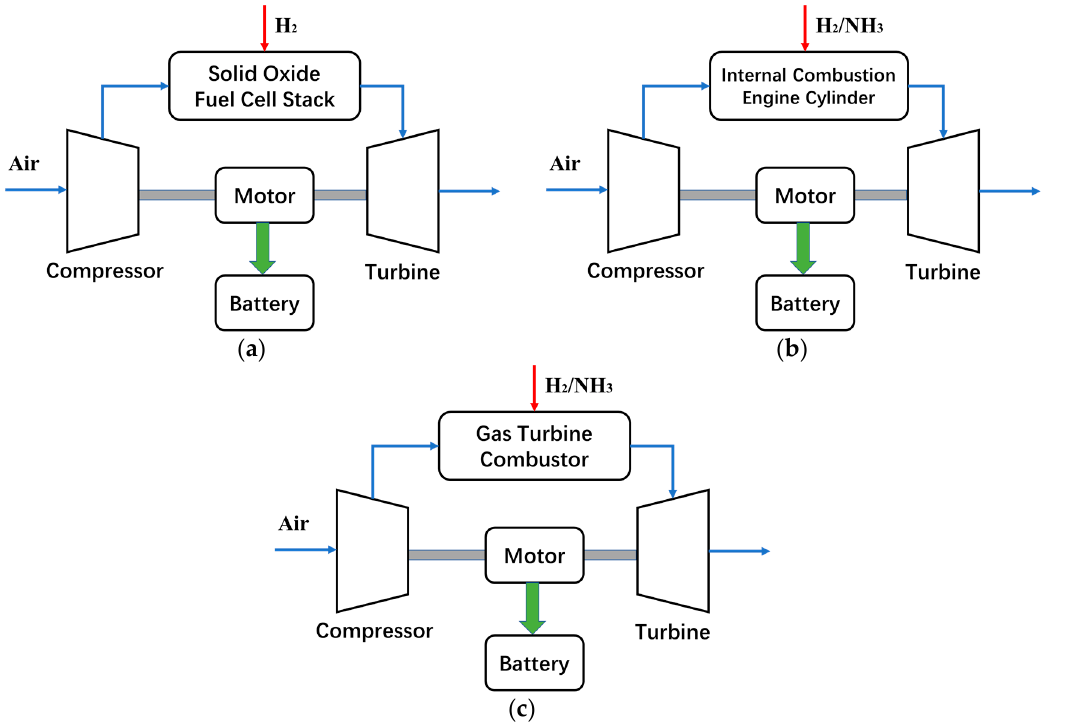
Figure 1. Schematic of hydrogen turbo hybrid power systems. ( a ) Hydrogen is oxidized in the SOFC stack. ( b ) Hydrogen/ammonia is burned in the ICE cylinder. ( c ) Hydrogen/ammonia is burned in the gas turbine combustor.